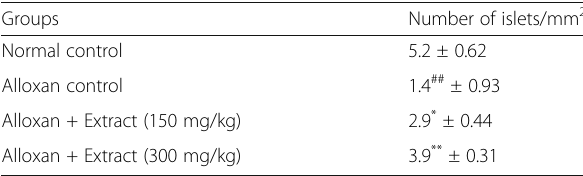
Table 2 The number of islets/mm 2 in the control and treatment groups